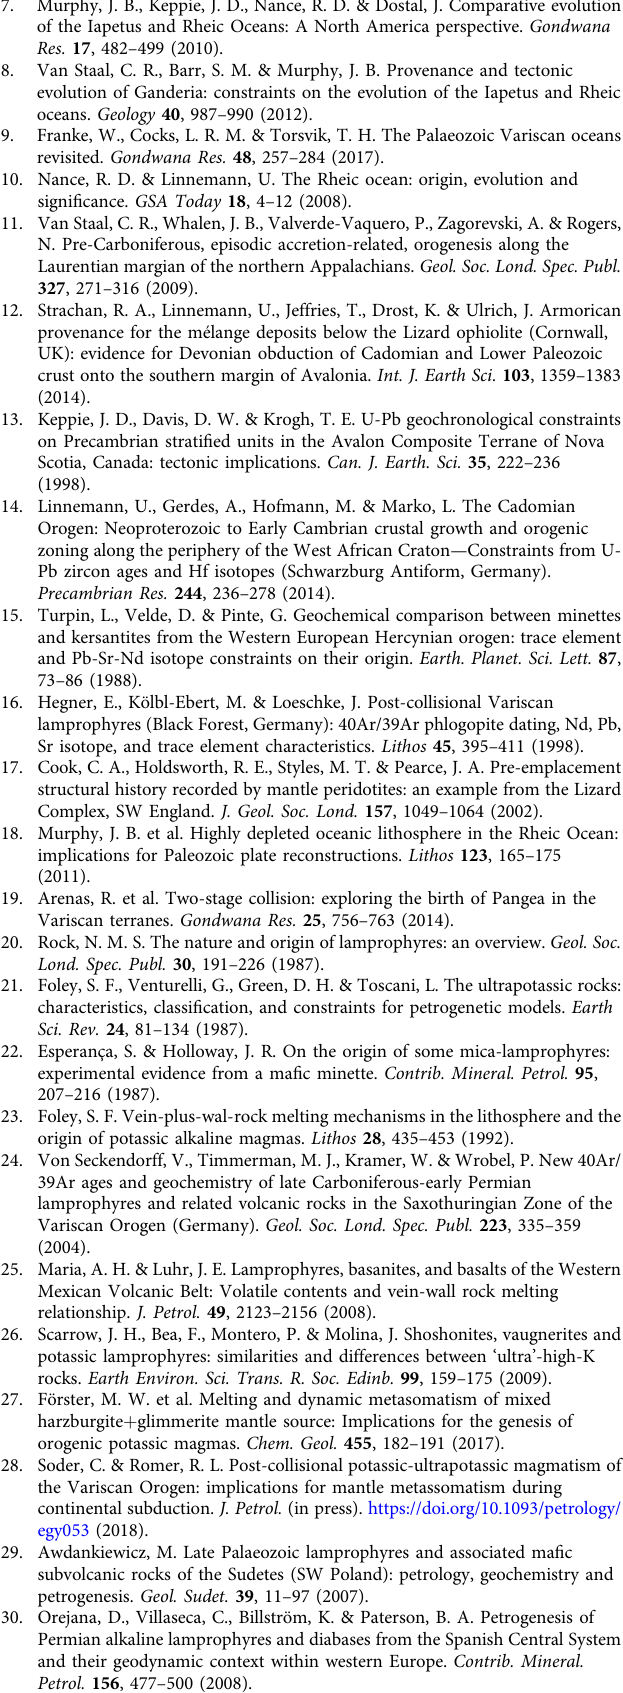
taken from the same localities (KIL, DUN, MAW, PEN, KHQ and POS) as reported by these authors were very well reproduced in our study, with relative deviations <0.007%. A similar comparison with published results for age-corrected 87 Sr/ 86 Sr isotope ratios for samples from localities KIL and DUN 33 yielded relative deviations of 0.024% and 0.002%, respectively. Compositions of the depleted mantle (DM), chondritic uniform reservoir (CHUR), uniform reservoir (UR) and the ‘ mantle array ’ line connecting these reservoirs in Fig. 3 at 290Ma were calculated using commonly used values: DM ( 143 Nd/ 144 Nd = 0.513114, 147 Sm/ 144 Nd = 0.2220, 87 Sr/ 86 Sr = 0.7025 and 87 Rb/ 88 Sr = 0.022); CHUR ( 143 Nd/ 144 Nd = 0.512638 and 147 Sm/ 144 Nd = 0.1967); and UR ( 87 Sr/ 86 Sr = 0.7045 and 87 Rb/ 86 Sr = 0.0827).